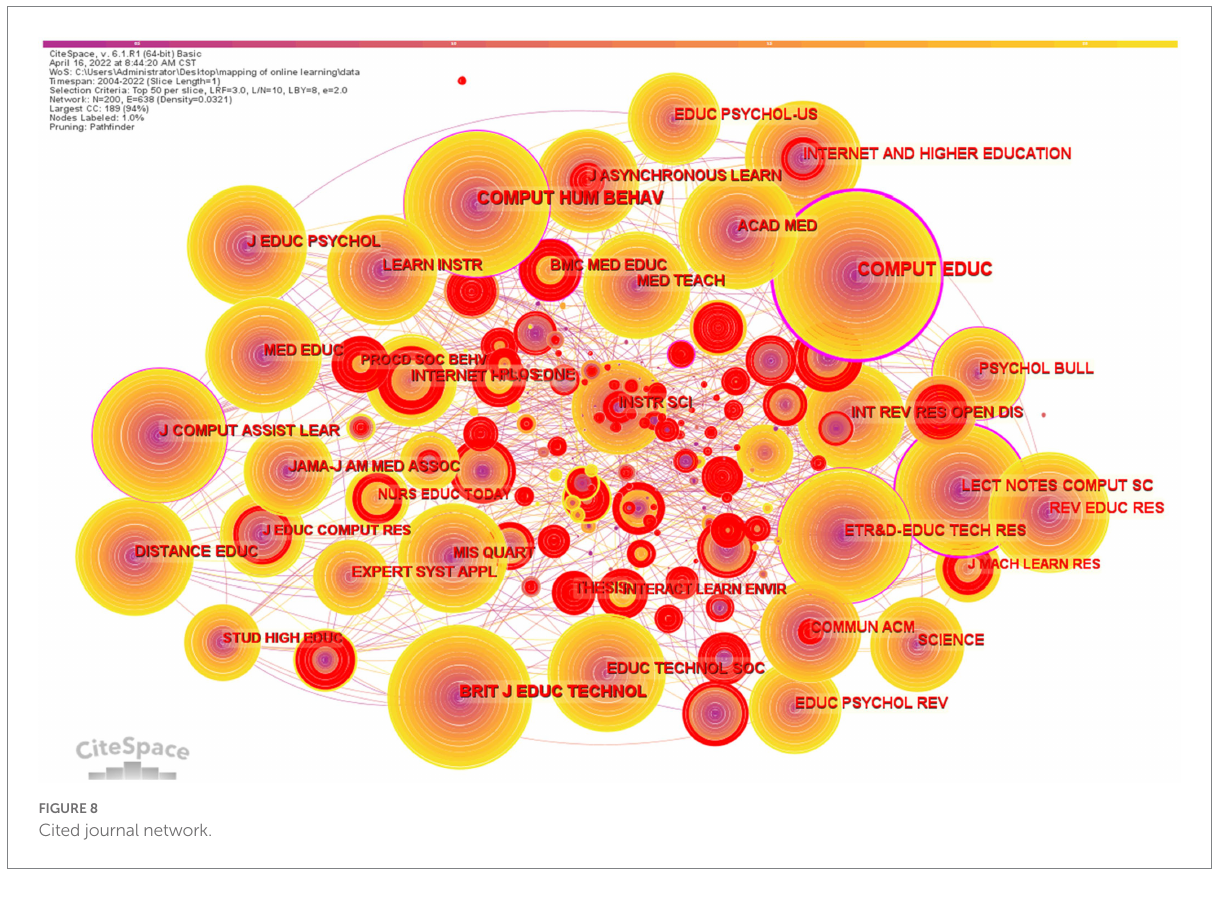
TABLE 10 Journals with 600+